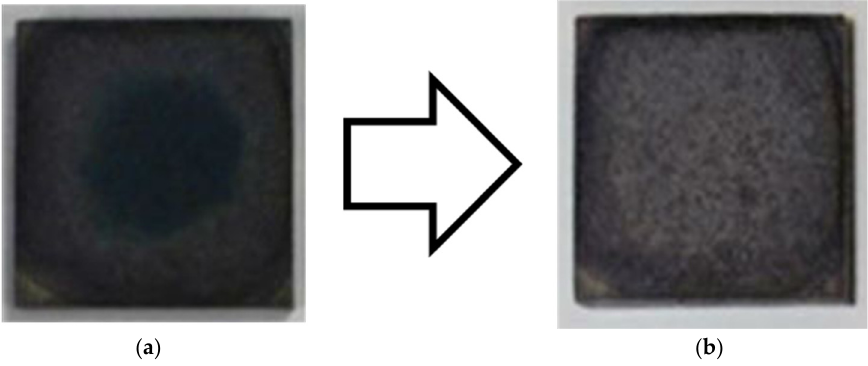
Figure 12. Results of methylene blue decoloration test when the coating was deposited at d = 80 mm ( d = deposition distance). ( a ) Before UV irradiation; ( b ) After 7 ‐ day UV irradiation.